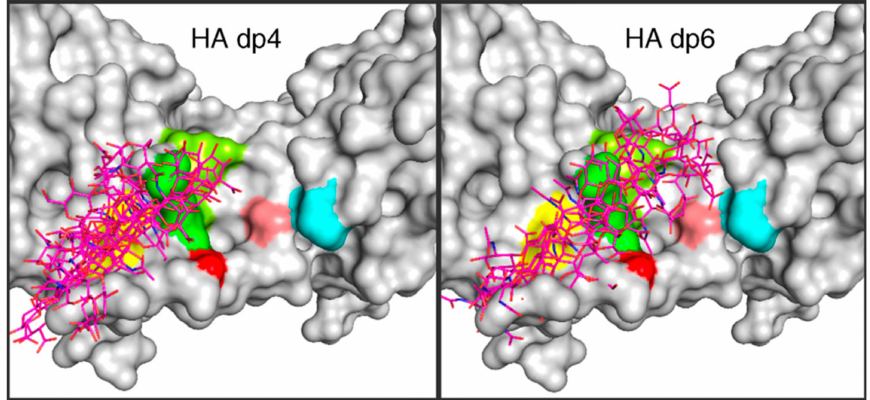
Figure 6. Ensemble of computationally predicted binding poses for hyaluronan 4-mers (“HA dp4”) and 6-mers (“HA dp6”) with IL-10. Dynamic Molecular Docking (DMD) [165] was used to generate the ensemble. DMD is an atomic-resolution explicit-solvent molecular dynamics method where full flexibility of both the protein and ligand are allowed throughout a molecular dynamics trajectory during which the ligand is gradually pulled toward the protein. Reprinted with permission from Ref. [154]. Copyright 2015